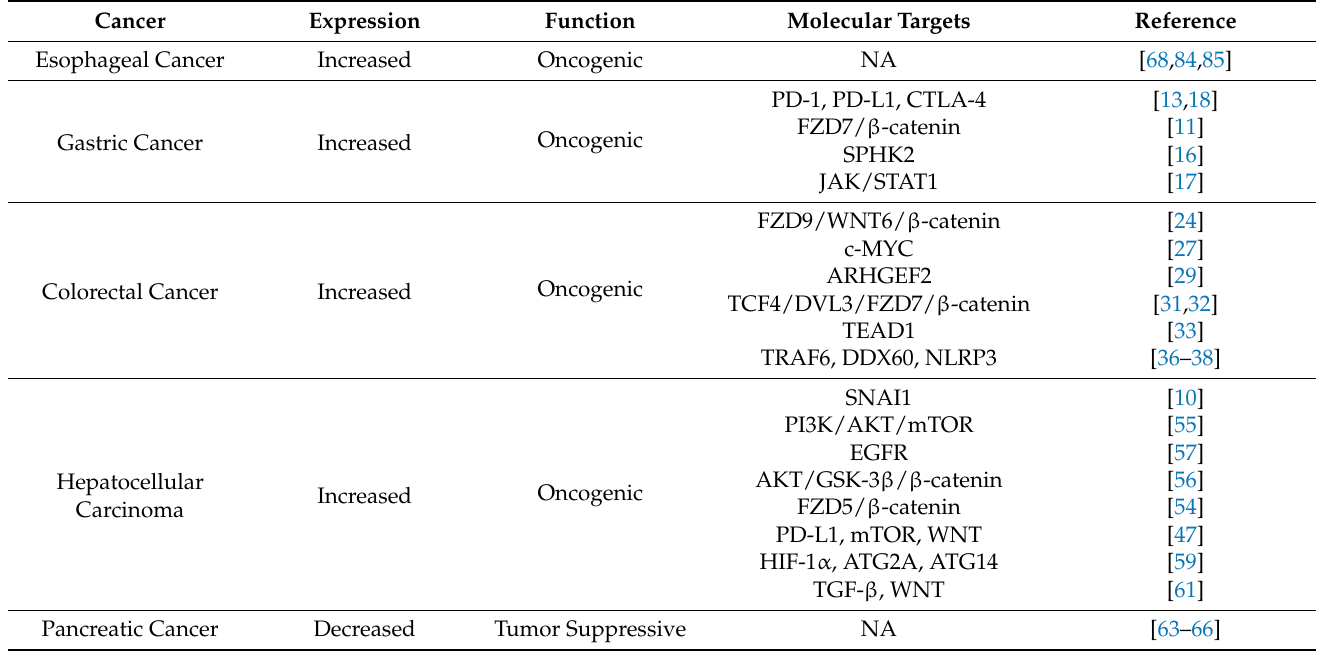
Table 1. Characteristics of YTHDF1 in Gastrointestinal